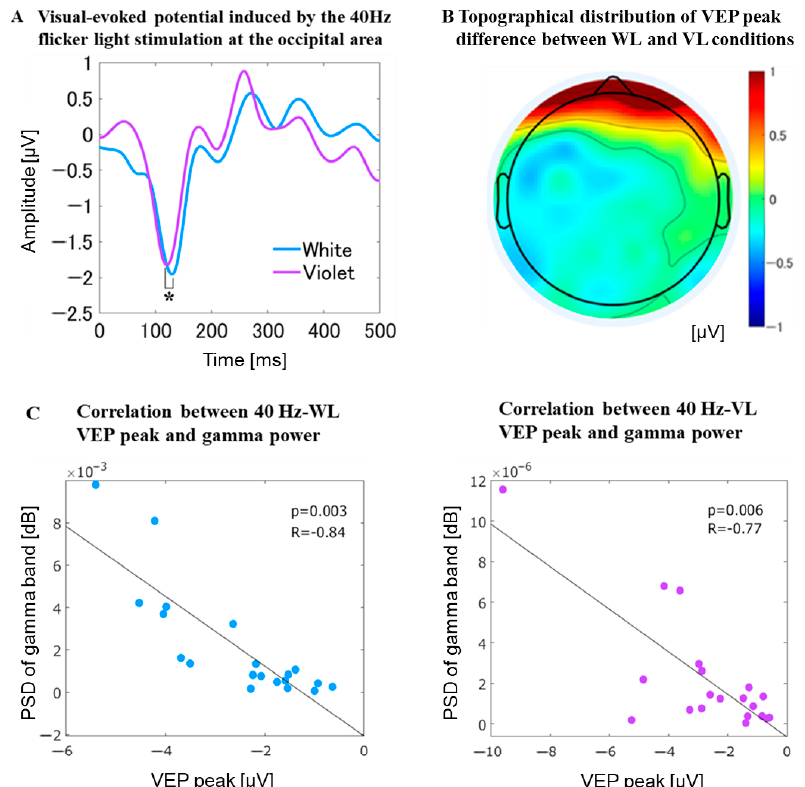
Figure 7. Visual-evoked potential at the occipital area. ( A ) represents the VEP at the occipital area (Oz electrode site). The negative peak of VEP appeared around 100 ms with 40 Hz-WL stimulation, whereas the corresponding negative peak of VEP with 40 Hz-VL was significantly smaller ( t 38 = 2.04, p = 0.032) than that of 40 Hz-WL. However, there was no significant difference in the negative peak latencies between the VEPs with 40 Hz-VL and the VEP with 40 Hz-WL; ( B ) depicts topographi- cal distribution of VEP peak difference between 40 Hz-WL and 40 Hz-VL stimulation conditions; ( C ) shows significant correlations between VEP peak and PSD of gamma-band during 40 Hz-WL stimulation as well as between VEP peak and PSD of gamma-band during 40 Hz-VL